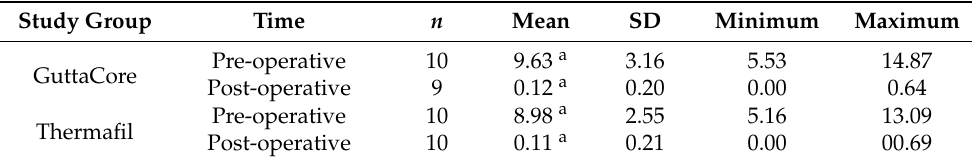
Table 1. Descriptive analysis of the pre-operative root canal filling material volume (mm 3 ) and the remaining post-operative root canal filling material volume (mm 3 ) at the coronal third of the root canal systems.